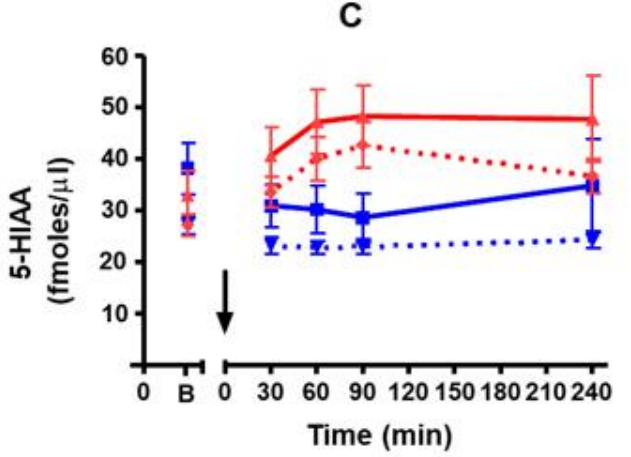
Figure 2. Levels of plasma kynurenine ( A ), KYNA ( B ) and 5-HIAA ( C ) at baseline and 30, 60, 90 and 240 min after oral administration of either placebo or TRP (6 g) in healthy controls (HCs, n = 16) and people with schizophrenia (SZ, n = 22) (arrows). Data are the mean ± SEM. Kynurenine ( p < 0.001), KYNA ( p < 0.001) and 5-HIAA ( p = 0.038) increased after TRP challenge in both groups. See text for further details.